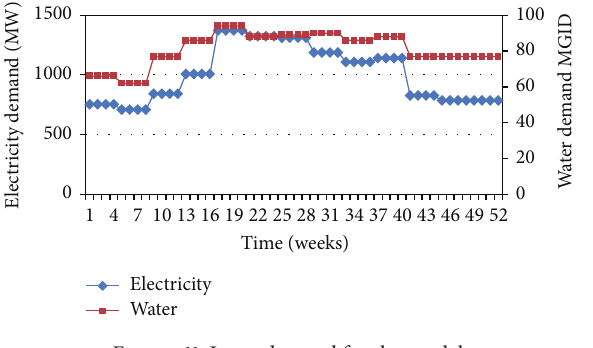
and ItIn = 50 , with solution time 78 sec. Both are obtained using 4-point crossover.